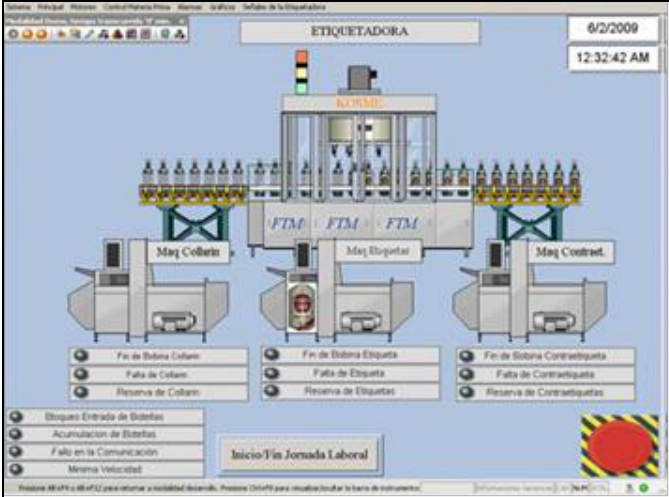
Figura 6: Etiquetadora. Fuente: Los Autores,